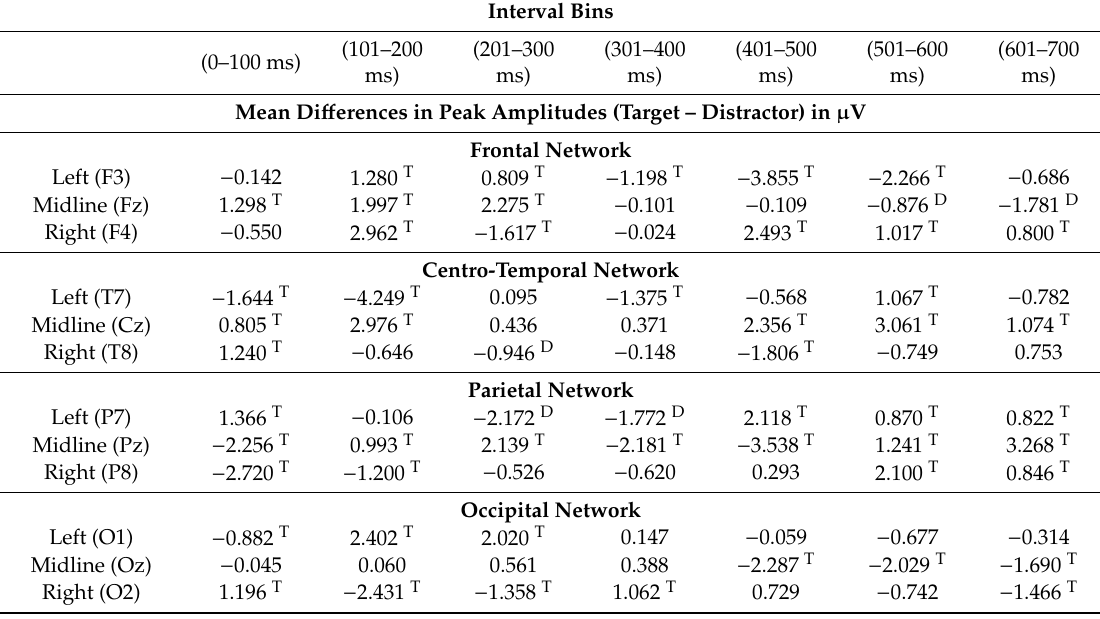
Table 2. Di ff erences of average peak ERP amplitudes and corresponding latencies in target and distractor conditions (absolute value of (peak amplitude target – peak amplitude distractor)) within interval bins of 100 ms of epoch range (0 to 700 ms) for all